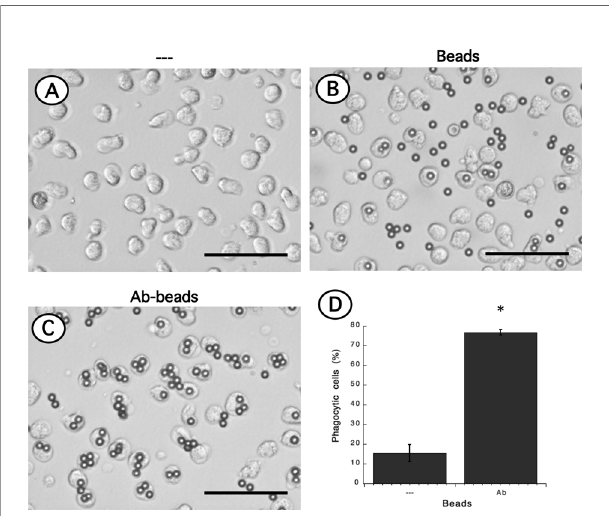
FIGURE 7 | Phagocytosis of antibody-opsonized beads by neutrophils. Neutrophils alone (A) or mixed with non-opsonized latex beads (B) , or with antibody-opsonized latex beads (Ab-beads) (C) were incubated for 30 min at 37°C to assess phagocytosis. Images are representative of 5 experiments with similar results. Scale bar represents 50 µm. (D) Percentage of phagocytic neutrophils for non-opsonized ( – ), or antibody-opsonized (Ab) beads. Data are mean ± SEM of 5 separate experiments. Asterisk (*) denotes conditions that are statistically different between non-opsonized and antibody- opsonized beads (p <